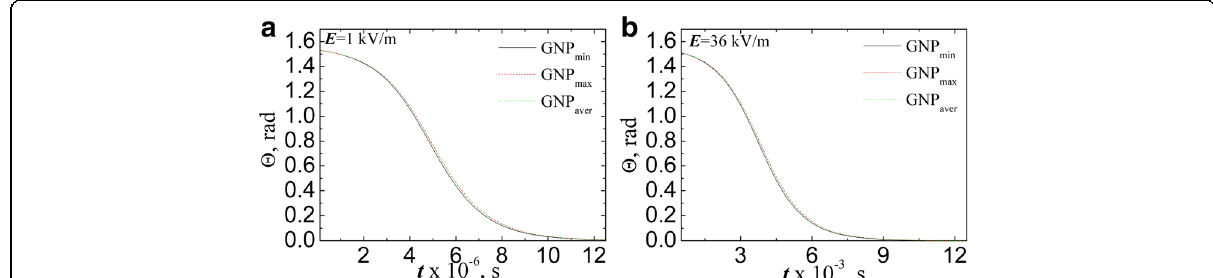
Fig. 9 The evolution of the angle of GNPs inclination relative to the field direction estimated in spheroid approximation ( L x was taken by the Eq. (4)) at AC electric field strength 1 kV/m ( a ) and 36 kV/m ( b )